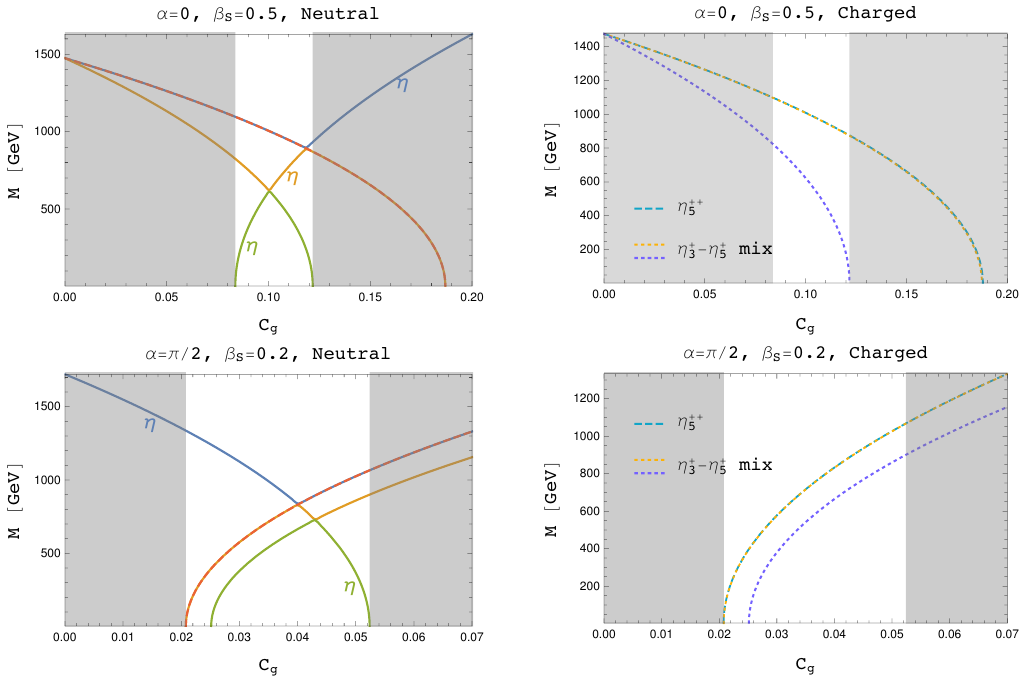
Figure 6 . Neutral and charged spectra in the D L - S R case for two benchmark points corresponding to (cid:11) = 0 and (cid:12) S = 0 : 5 (top row), and (cid:11) = (cid:25)= 2 and (cid:12) S = 0 : 2 (bottom row). For the (cid:12)rst